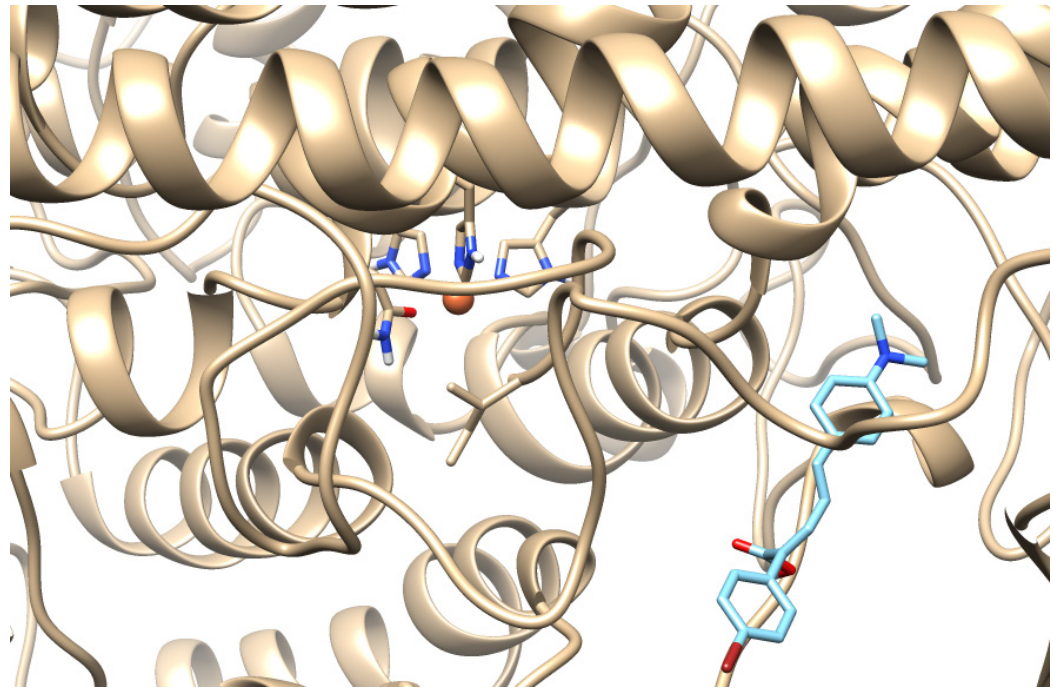
Figure 2. Docking pose of 3i (depicted in blue) bound to soybean lipoxygenase (LOX-1). The iron ion is depicted as an orange sphere.